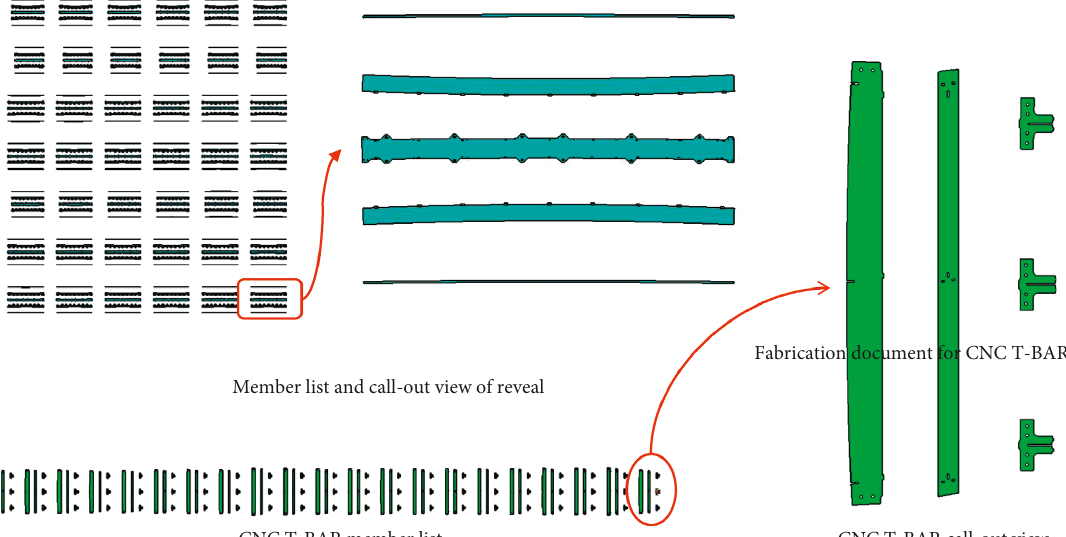
Figure 9: Planar figure example of CNC T-BAR and